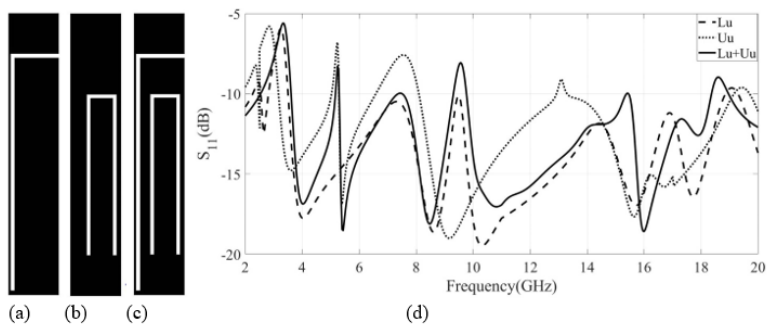
Figure 6. ( a ) Addition of L-shaped notching element with L u = 11 mm to the radiating patch; ( b ) Addition of U-shaped notching element with U u = 8 mm to the radiating patch; ( c ) Addition of both L-shaped and U-shaped notching elements L u + U u to the radiating patch; and ( d ) Effect of coupling of notching elements ( L u and U u ) on band rejection at WiMax and WLAN and the creation of third band rejection at X-band for satellite